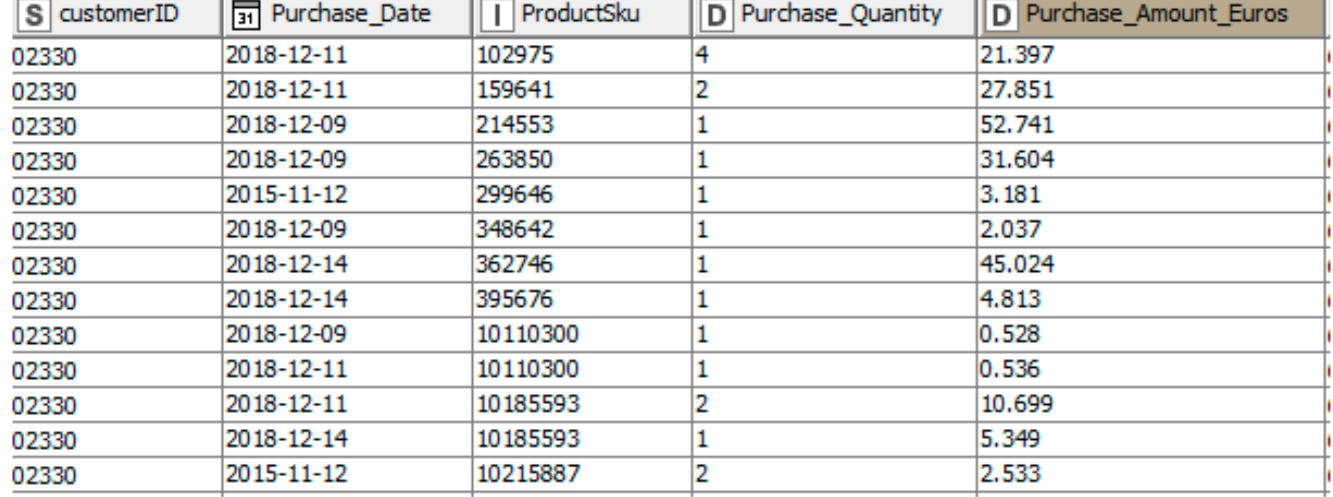
Figure 8. Example of data in an operational database from a